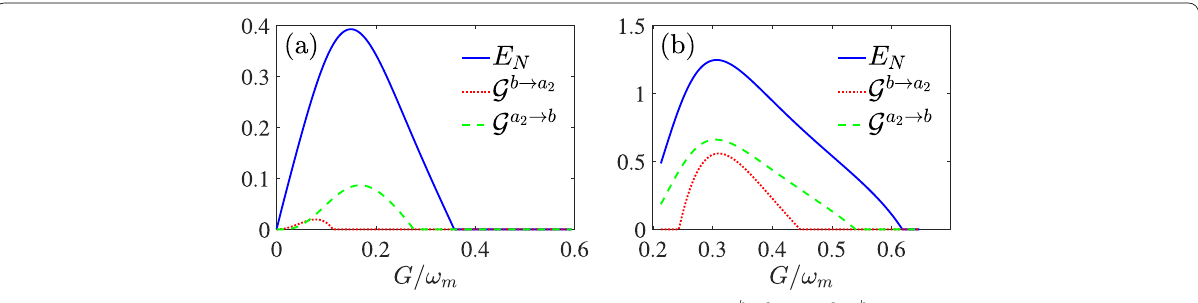
Fig. 2 The steady‑state optomechanical entanglement E N ( b , a 2 ) and steering parameters G b → a 2 and G a 2 → b versus the optomechanical coupling strength G for a (cid:31)